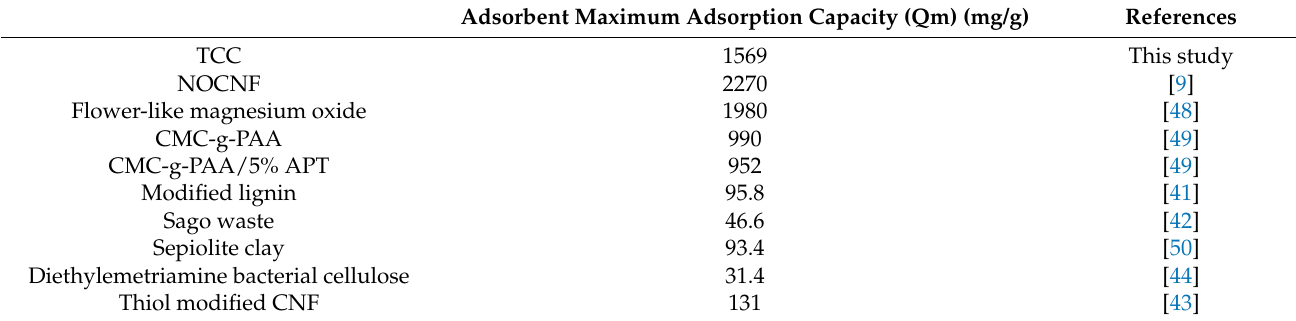
Table 2. Comparison of the Maximum Adsorption Capacity (Qm) Value Obtained from TCC with Different Types of Adsorbent Reported in the